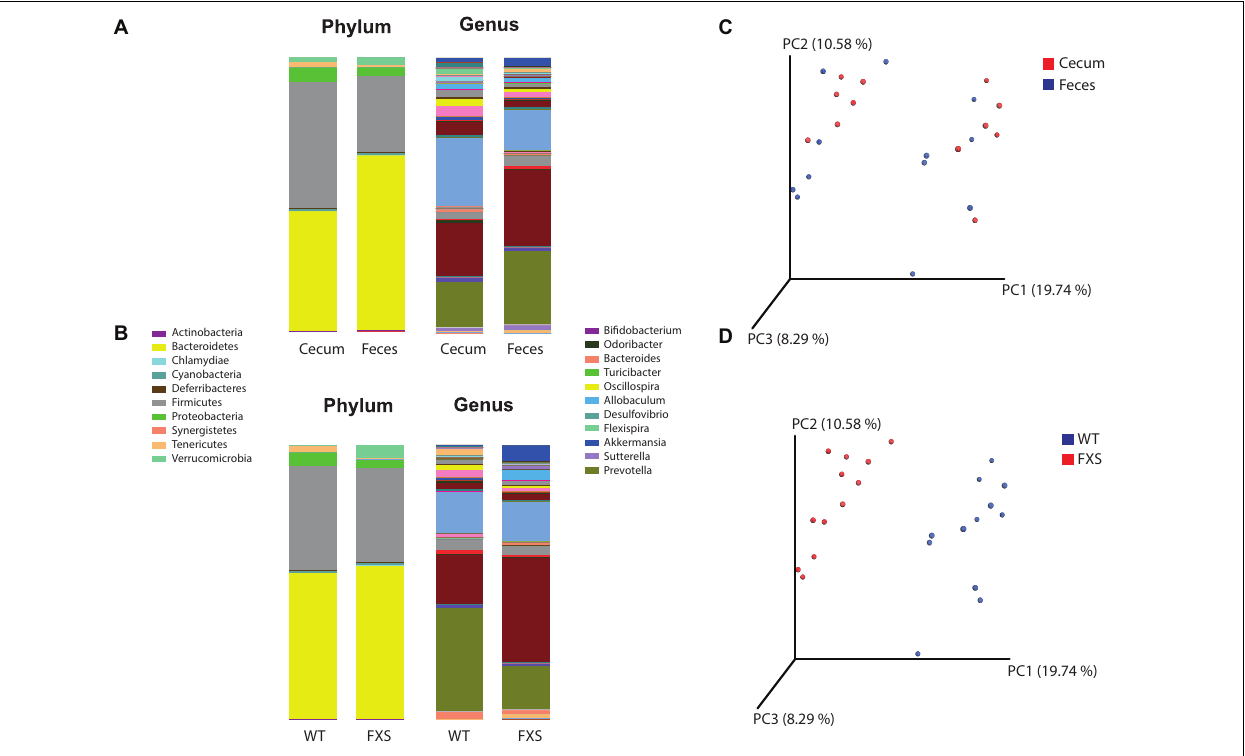
FIGURE 1 | Operational Taxonomic Units (OTU) based analysis according to panel (A) sample type and to panel (B) genotype, for the phyla and genera taxonomic levels of bacteria. Principal coordinates analysis (PCoA) was used for calculation of beta diversity of the OTU-based bacterial communities. In panel (C) are presented the PCoA plots according to the sample type (cecum and feces) and in panel (D) to the genotype (FXS and WT).